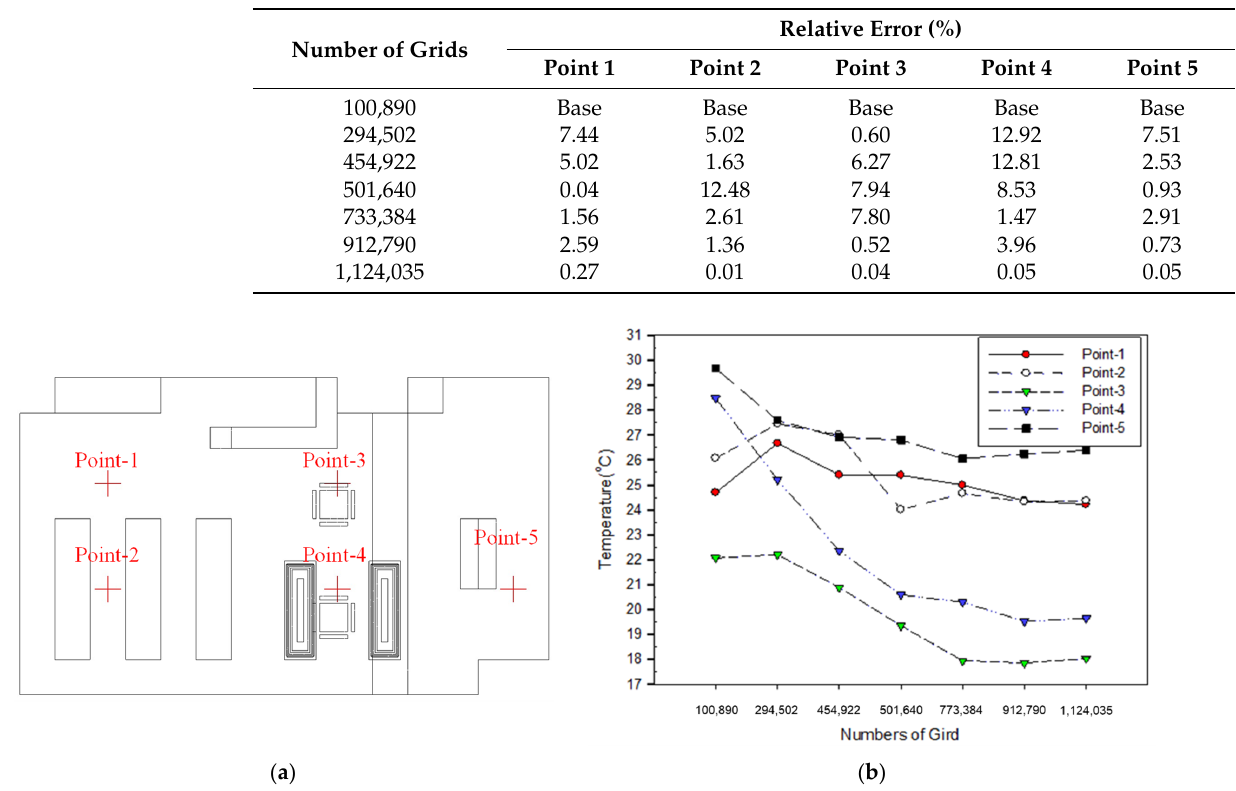
Figure 5. The measured temperature at the CSS middle aisle in the C-C’ section plane. After conducting the analysis based on energy consumption and the ambient tem- perature of the baseline energy usage intensity (EUI) of convenience stores could be de- rived from simulation data accordingly. Figure 6. shows the energy consumption for each AC under daily and monthly conditions. There is the highest power consumption in the daily and monthly conditions. The line graph illustrates the amount of two kinds of AC